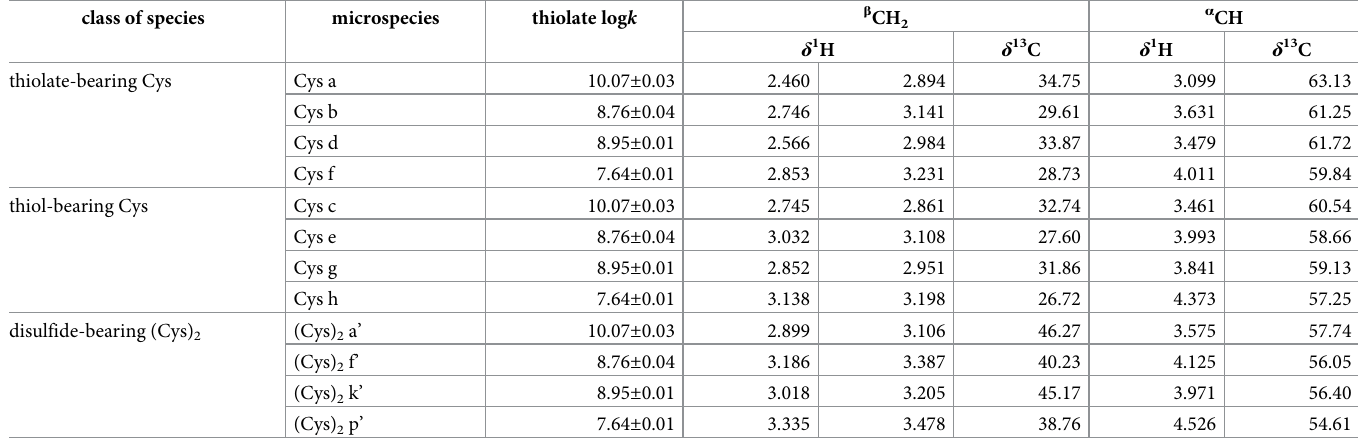
Table 1. The species-specific chemical shifts (on the ppm scale) determined for cysteine and cystine microspecies. The uncertainty of determination for chemical shift on the ppm scale is 0.001 and 0.01 for 1 H and 13 C chemical shift values, respectively. For the thiol- and disulfide-bearing species, the concomitant thiolate protonation constant given in the third column refer to the relevant thiolate-bearing microspecies that give rise to such thiol- or disulfide-bearing species via protonation or oxidation, respectively. The thiolate protonation constants were determined previously in [9]. class of